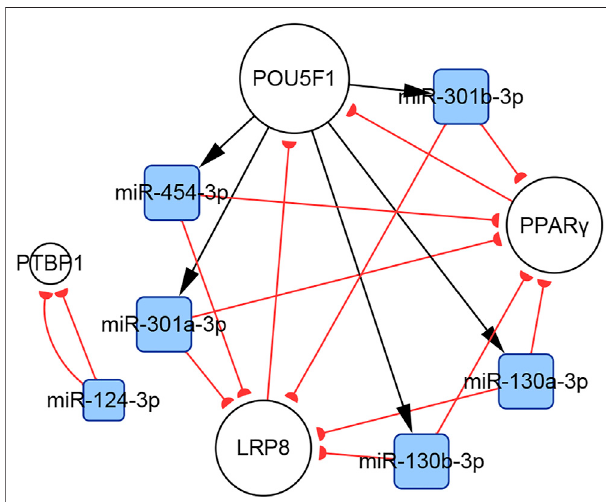
FIGURE5| ThePH-associated networkofncRNAsand theirinteracting RNAsorgenesinPAFs.ThesquareandcircularnodesrepresentncRNAsand coding RNAs or genes, respectively. Node color is based on the type of molecule (miRNAs are blue, coding RNAs or genes are empty). Node sizes represent the degrees (number of edges that directly link to the node). Edges represent regulatory connections. Each edge indicates a publication. When multiple publications describe one interaction, multiple edges connect the same two nodes. Red edges depict links indicating repressive action (semicircular arrow heads), and black edges are those indicating activation (traditional arrow heads). The nodes in this network were primarily involved in cell proliferation and extracellular matrix remodeling. PAFs: pulmonary artery fi